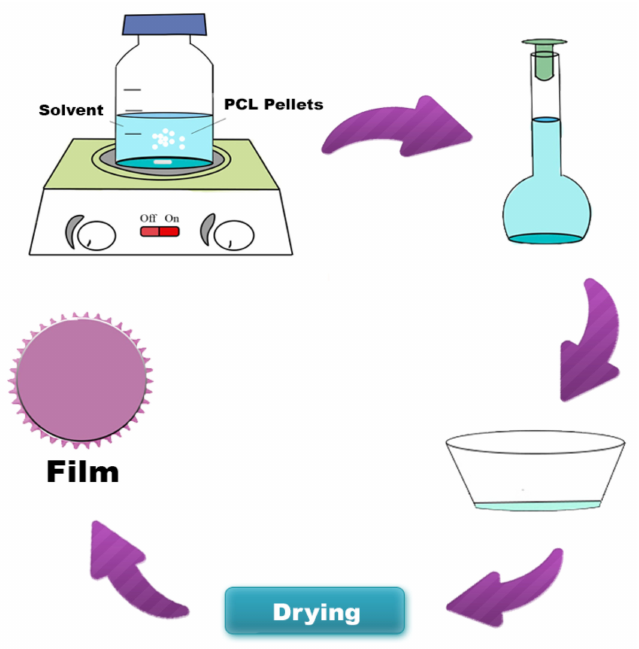
Figure 1. Schematic diagram of poly ( ε -caprolactone) (PCL) film synthesis by the solvent casting